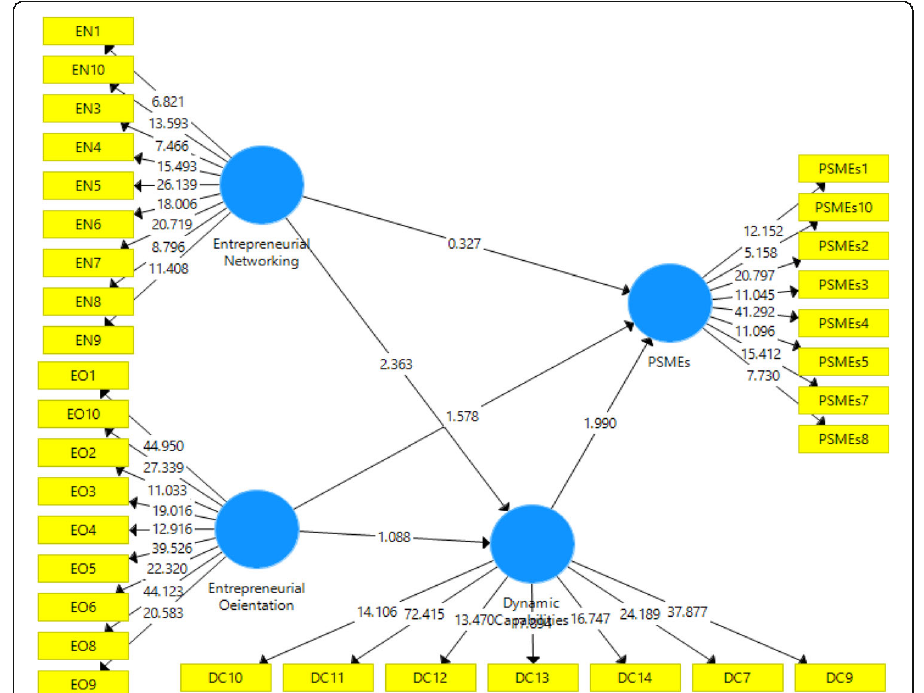
Table 5 Mediation effect bootstrapping Paths Original